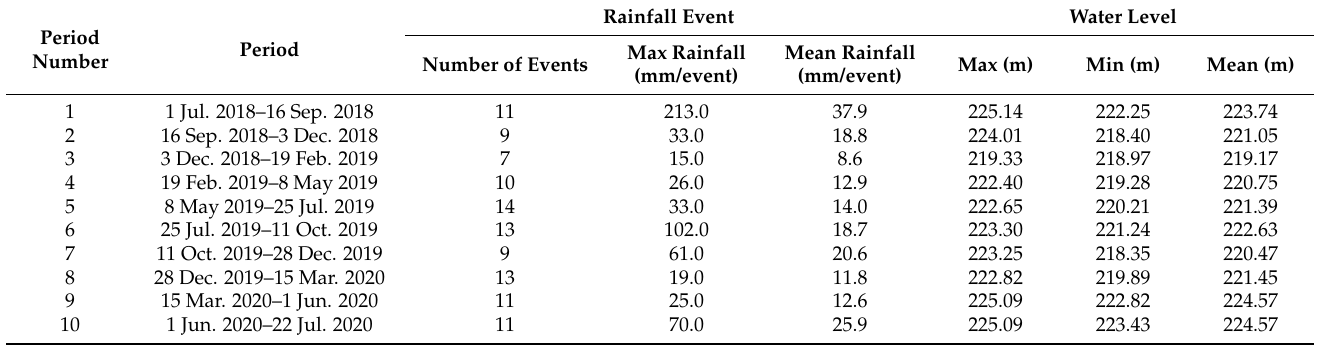
Table 5. Summary of rainfall and water level during the divided periods used for testing the LSTM ED1